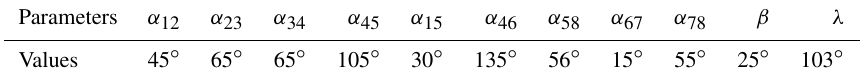
Table 5. The parameters for Example 2.